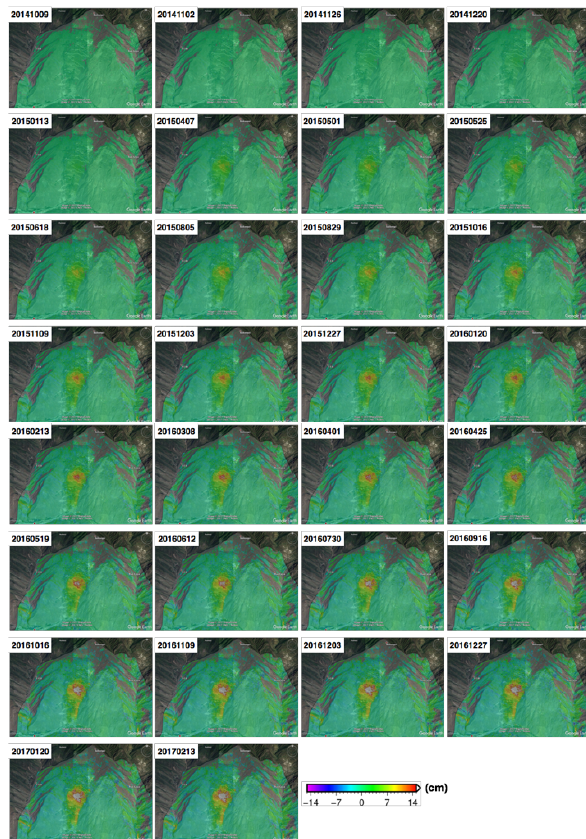
Figure 7. Time series evolutions of Xishancun Landslide acquired from Sentinel-1 datasets